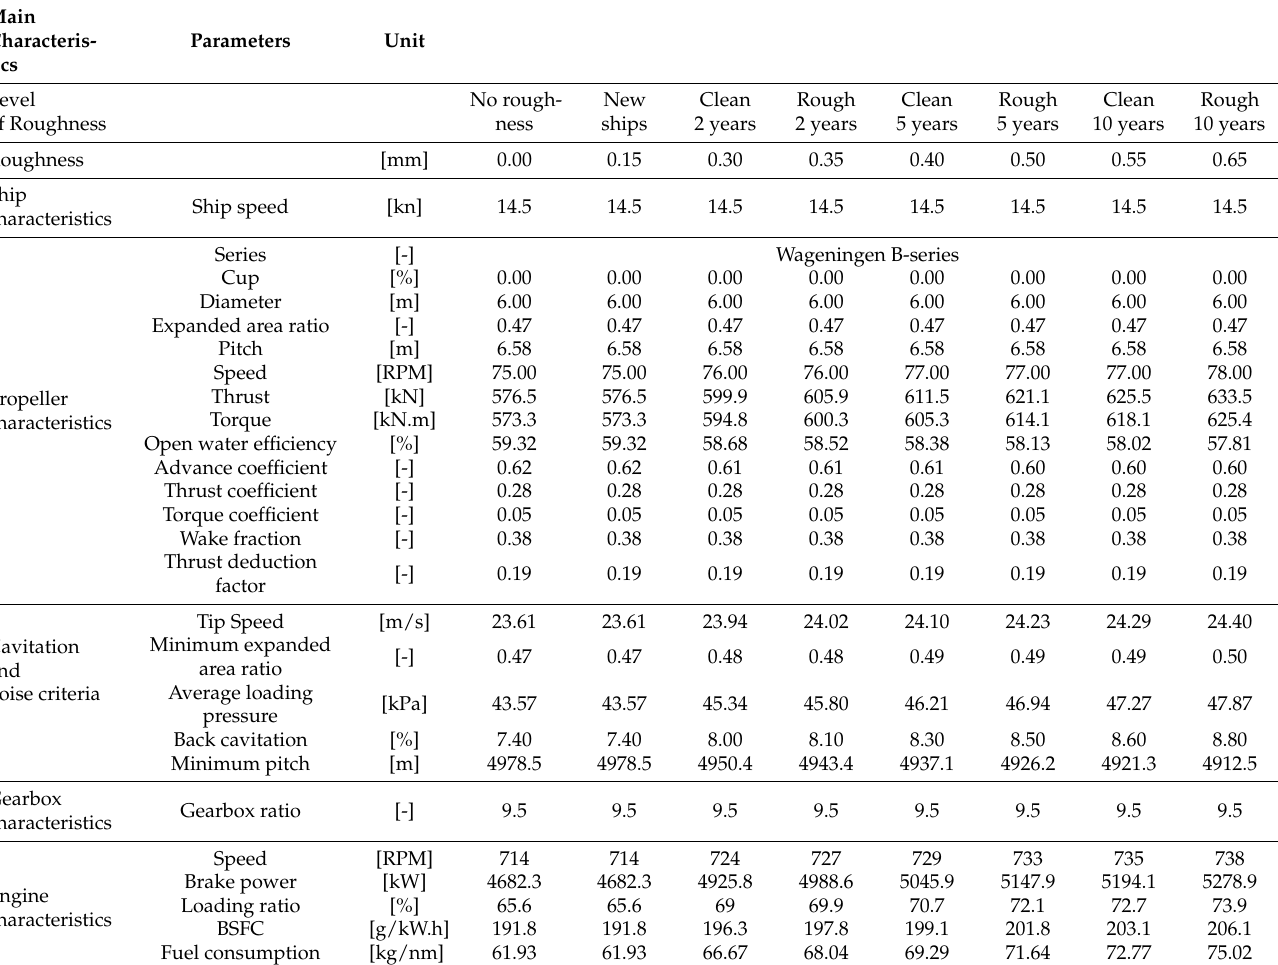
Table A1. Optimum results for different configurations.